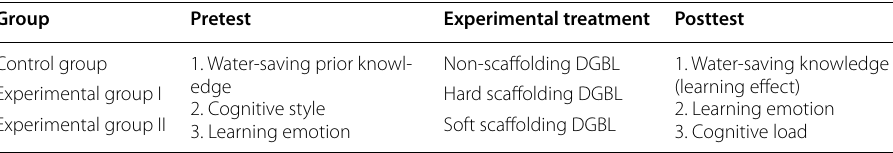
Table 1 Experimental